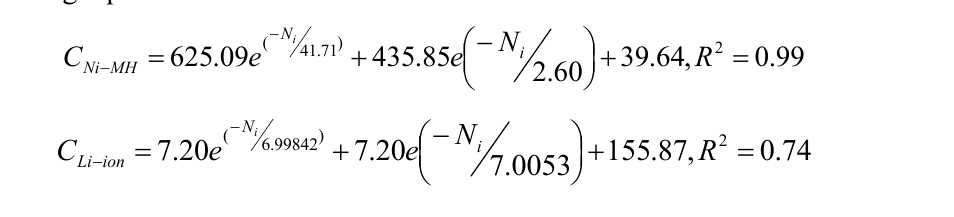
Figure 3. Cycle performance fits of the selected Ni-MH battery & Li-ion